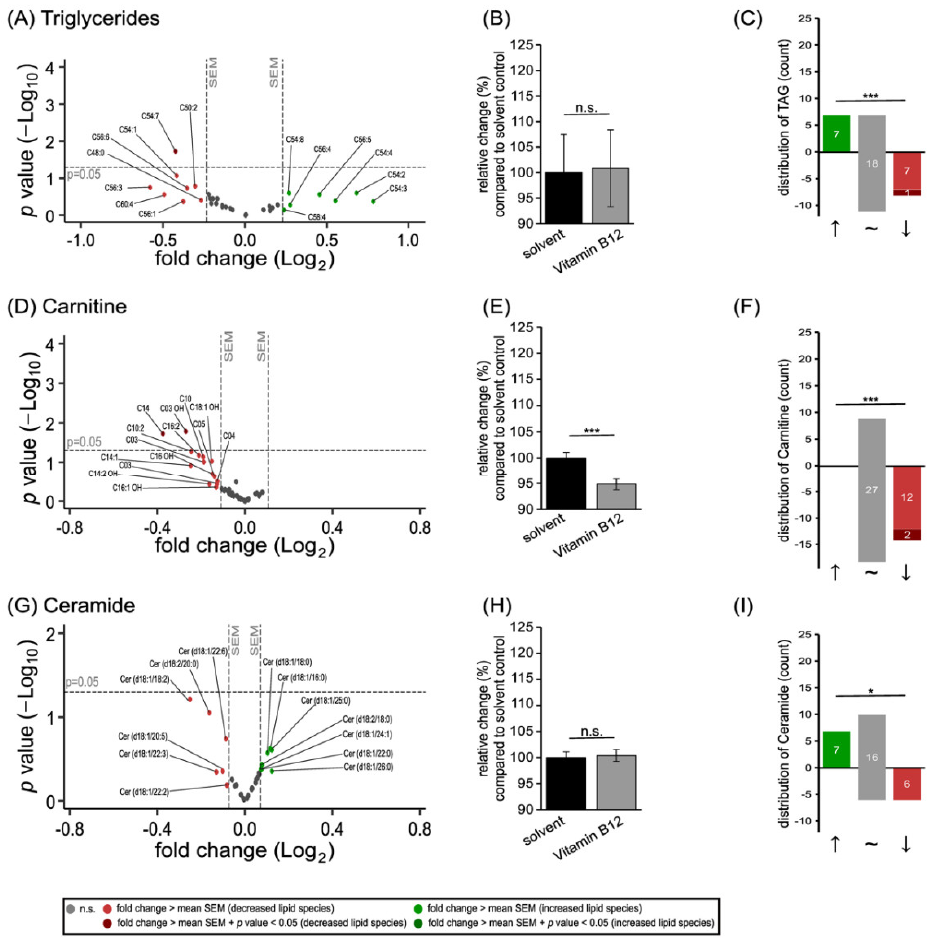
Figure 4. Effect of vitamin B12 treatment on the lipid species triglycerides, carnitines, and ceramides. SH-SY5Y cells treated with vitamin B12 compared to cells treated with the solvent control (HPLC water). In each of the volcano plots ( A , D , G ) the particular lipid species with its fold change (x-axis) in relation to its p -value (y-axis) is shown as a dot. Plots are structured as in Figure 1. ( B , E , H ) The bar chart shows the relative fold change in the particular lipid species after vitamin B12 treatment, in comparison to treatment with the solvent control. ( C , F , I ) Distribution of the particular lipid species structured according to the amount of increased, unchanged, or decreased species. Statistical significance was set as * p ≤ 0.05, and *** p ≤ 0.001 (n.s.: not significant).